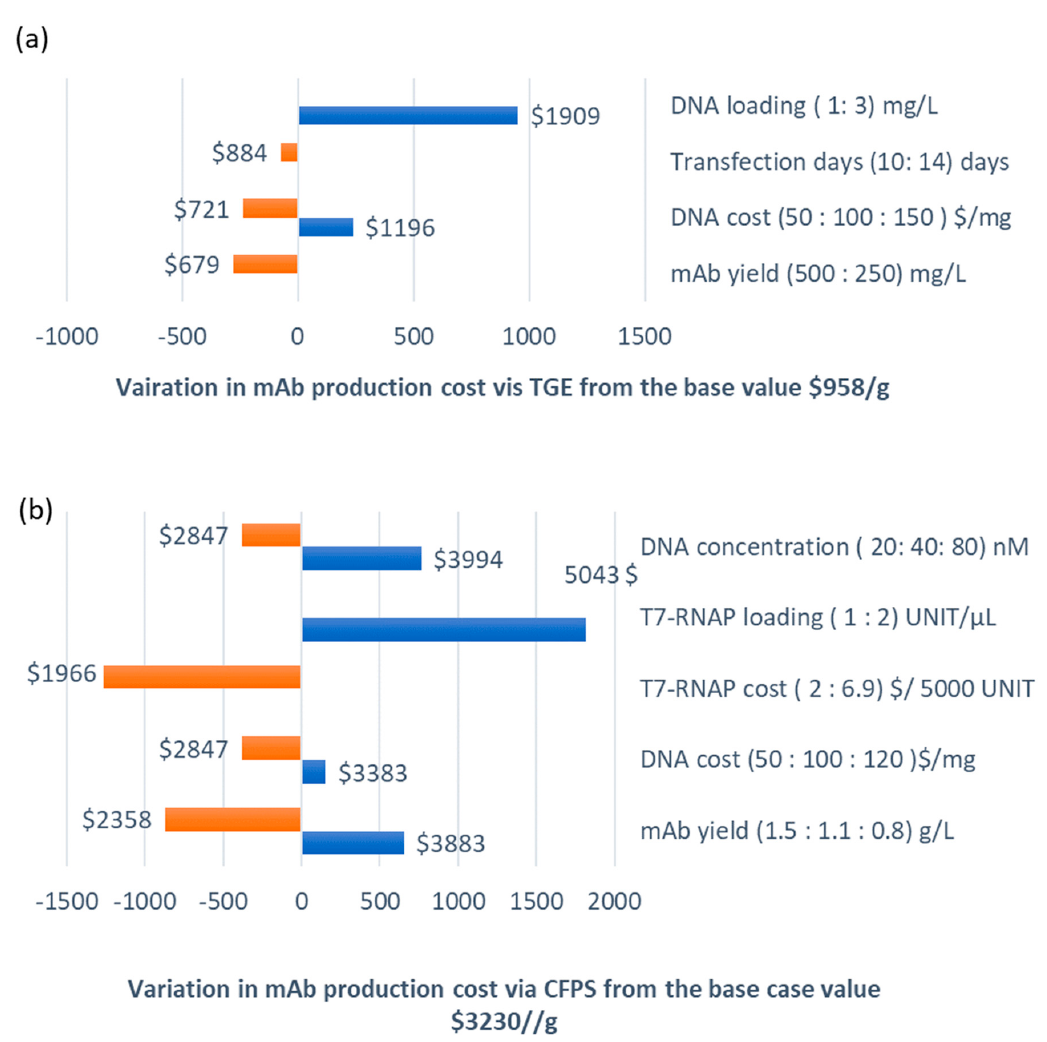
Figure 2. Sensitivity analysis of the mAb production cost for small scale manufacturing, 25 kg mAb/year via ( a ) TGE, base case mAb production cost = $958/g and ( b ) CFPS, base case mAb production cost =